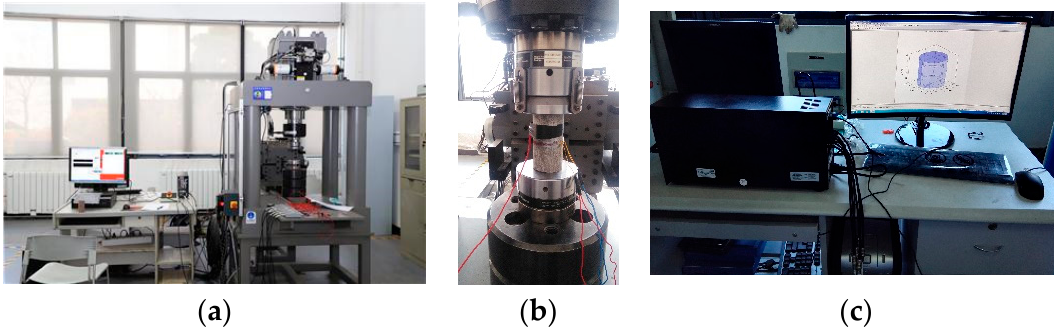
Figure 3. Photos of experimental system. ( a ) Loading system, ( b ) specimen pedestal, and ( c ) specimen